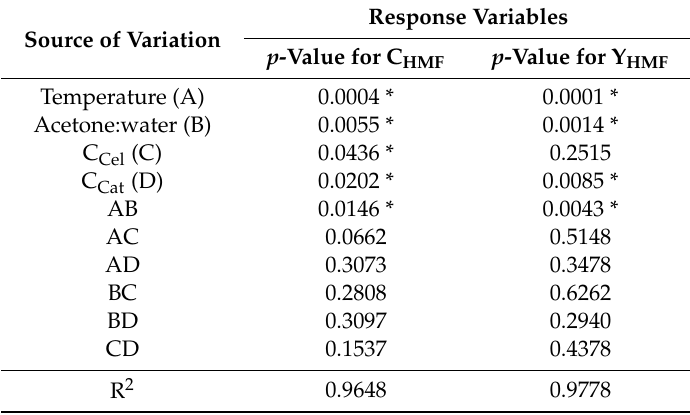
Table 2. Analysis of variance of the main e ff ects and their interactions on HMF concentration (C HMF ) and HMF yield (Y HMF ) based on Taguchi’s L 16 orthogonal